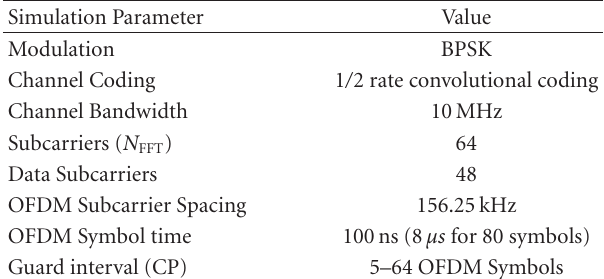
Table 4: OFDM simulation